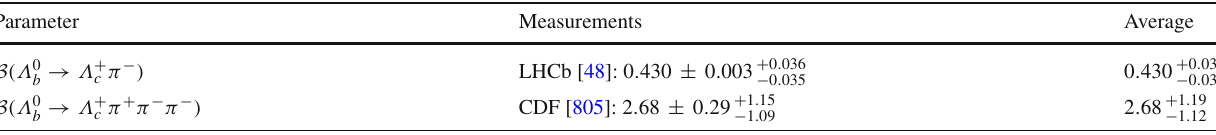
Table 213 Absolute decay rates [ 10 − 2 ]